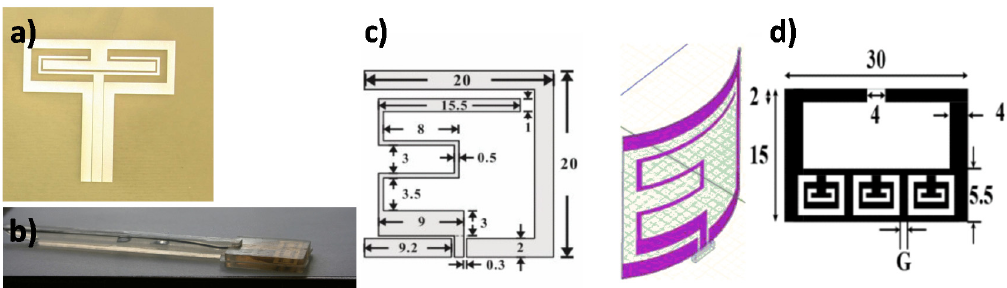
Figure 13. Implantable antennas. ( a ) Implantable slot antenna, ( b ) embedded in PDMS [222], ( c ) Geometry of low specific absorption rate (SAR) antenna and its prototype [223], and ( d ) geometry of flexible implantable loop antenna with complementary split ring resonator (CSRR) [224].